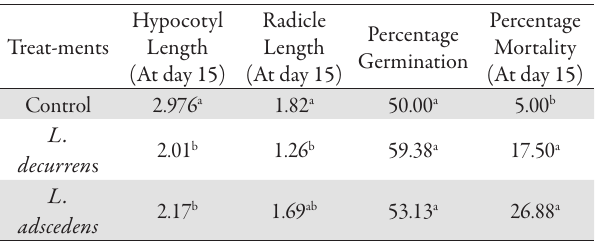
Tab. 1. Mean hypocotyl and radicle length, percentage